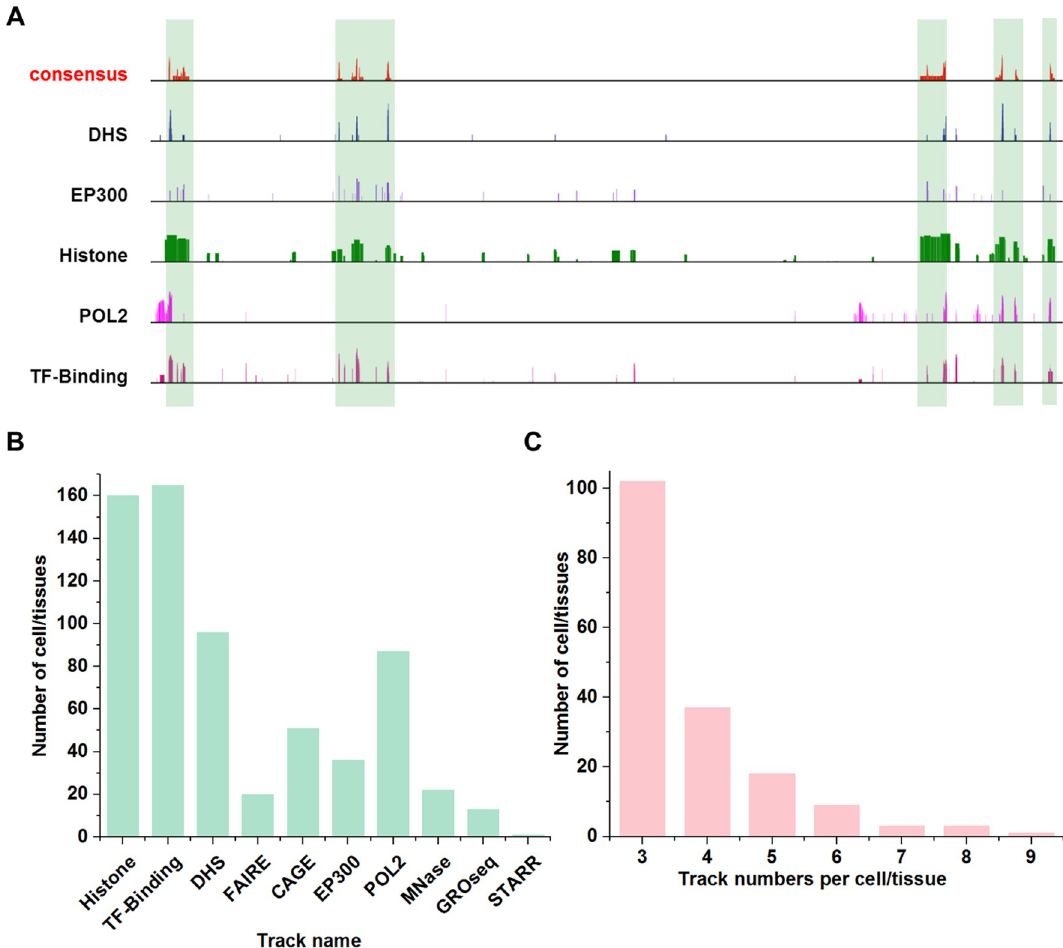
Fig 8. Enhancer consensus annotation in mouse cells. ( A ) Consistency and discrepancies in enhancer annotation. Vertical bars mark the enhancers supported by many tracks. Note that many regions are only supported by one or a few tracks. ( B ) Number of tissue/cell types that contain certain dataset types. Some technologies were more widely used than others for enhancer identification. ( C ) The number of cell/tissue types in function of the number of independent tracks. Many cell/tissue types include a few tracks (e.g. 3 or 4), while a few cell/tissue types have many tracks (e.g. 8 or